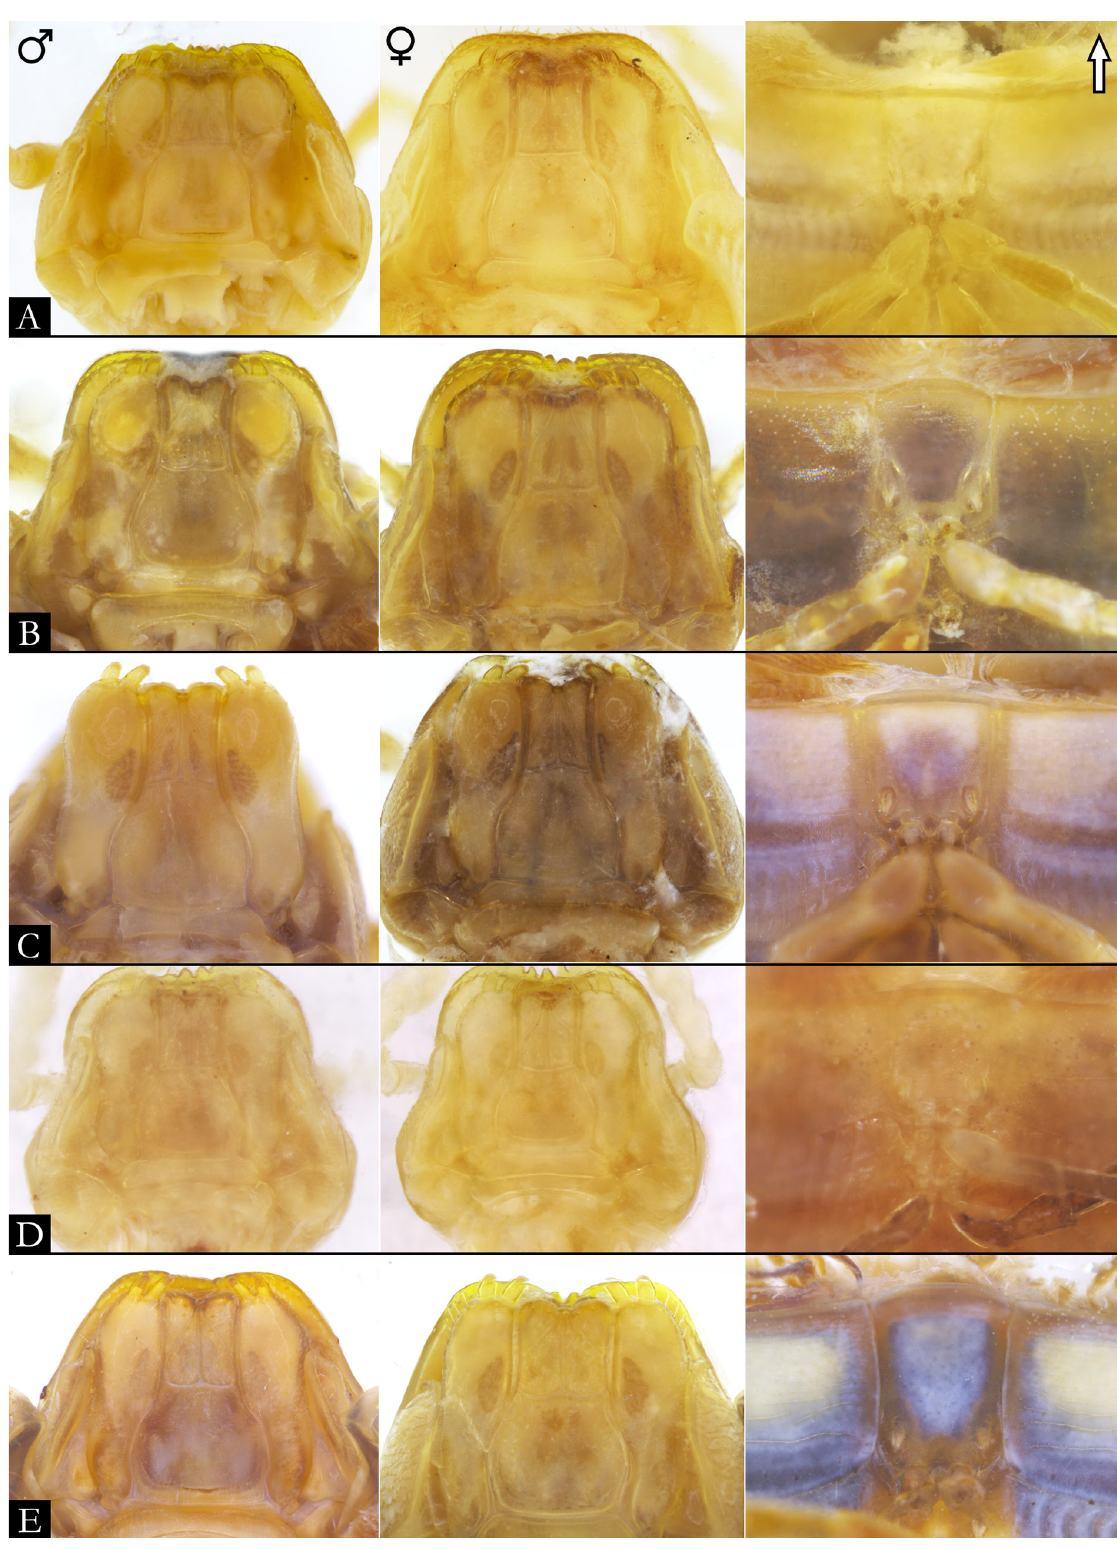
Fig. 169. Stereoscopic images of gnathochilarium and anterior sternum of species of Pseudonannolene Silvestri, 1895. A . P. imbirensis Fontanetti, 1996. B . P. inops Brölemann, 1929. C . P. leopoldoi Iniesta & Ferreira, 2014. D . P. leucocephalus Schubart, 1944. E. P. longicornis (Porat, 1888). Images not to